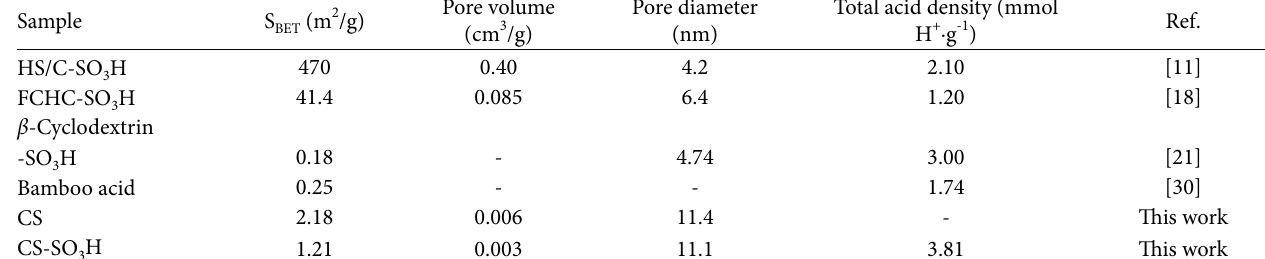
Table 1: The BET and acid density comparison different catalysts.